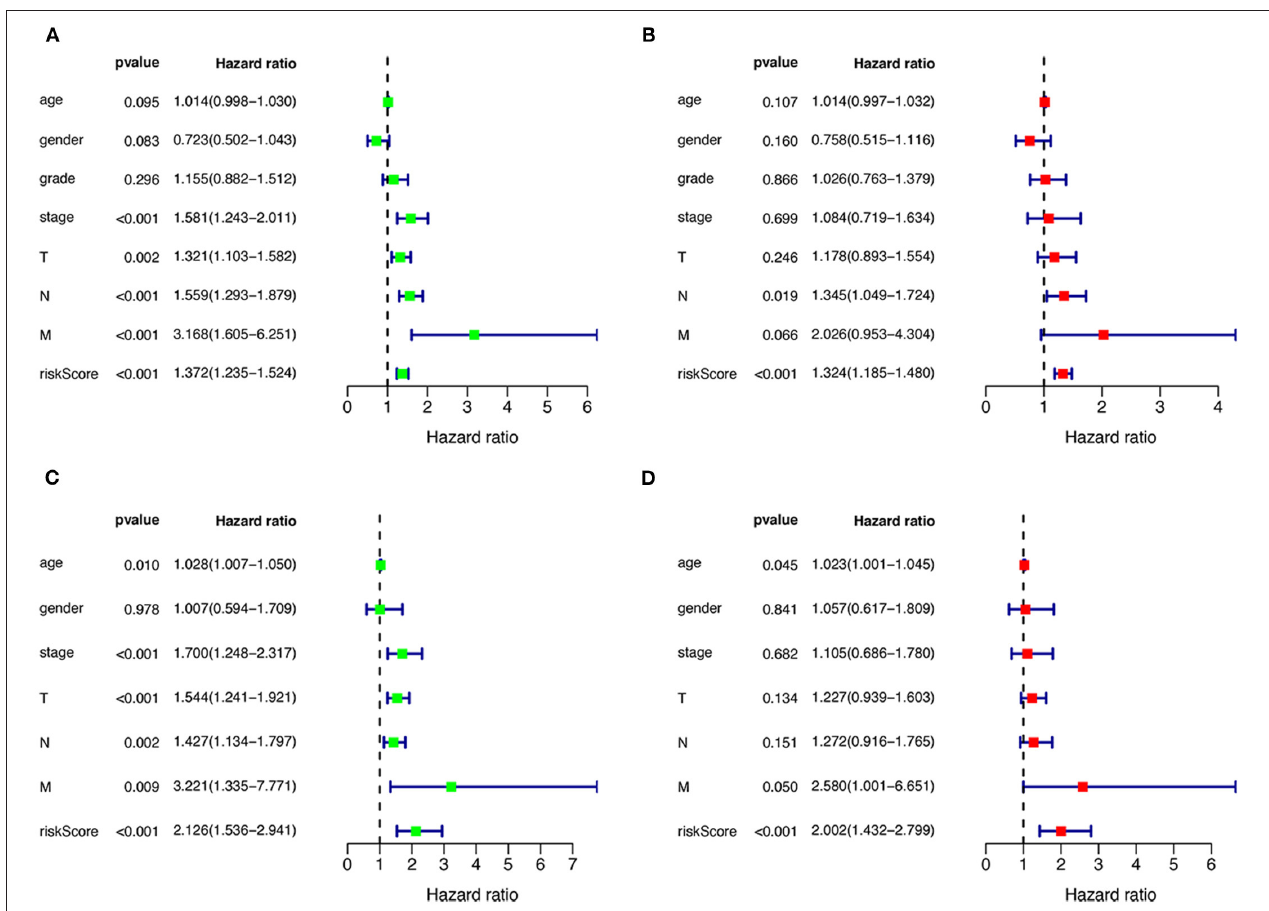
FIGURE 6 | Cox regression analysis to detect clinical independence of risk scores. Univariate (A) and Multivariate analysis (B) indicated that the risk score is an independent predictor variable in the TCGA dataset . (C, D) The Cox regression analysis also shows that the risk score can be independent of other clinical variables in the validation set